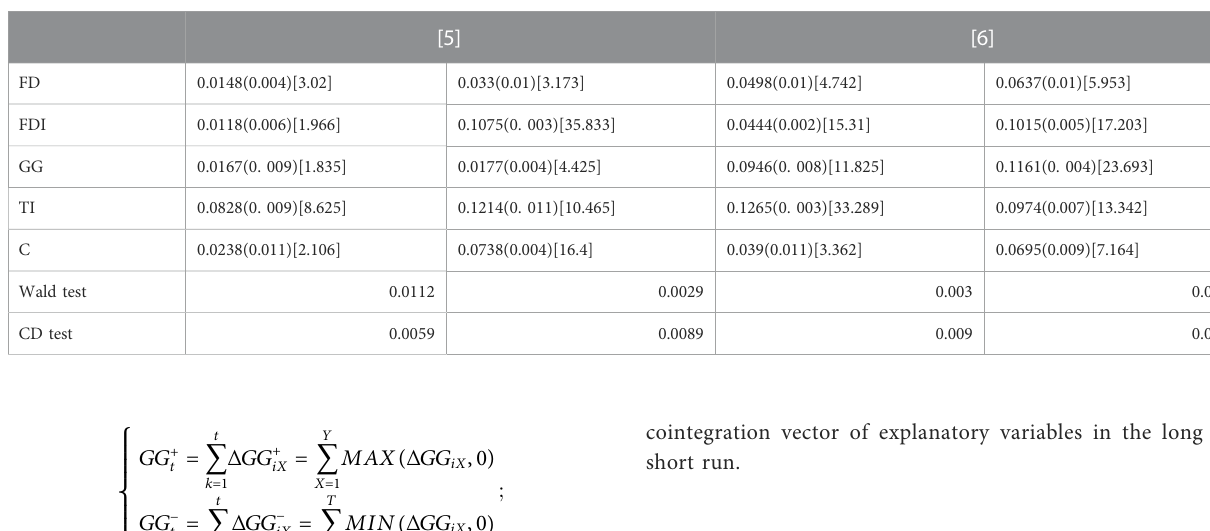
TABLE 12 Results of AMG and